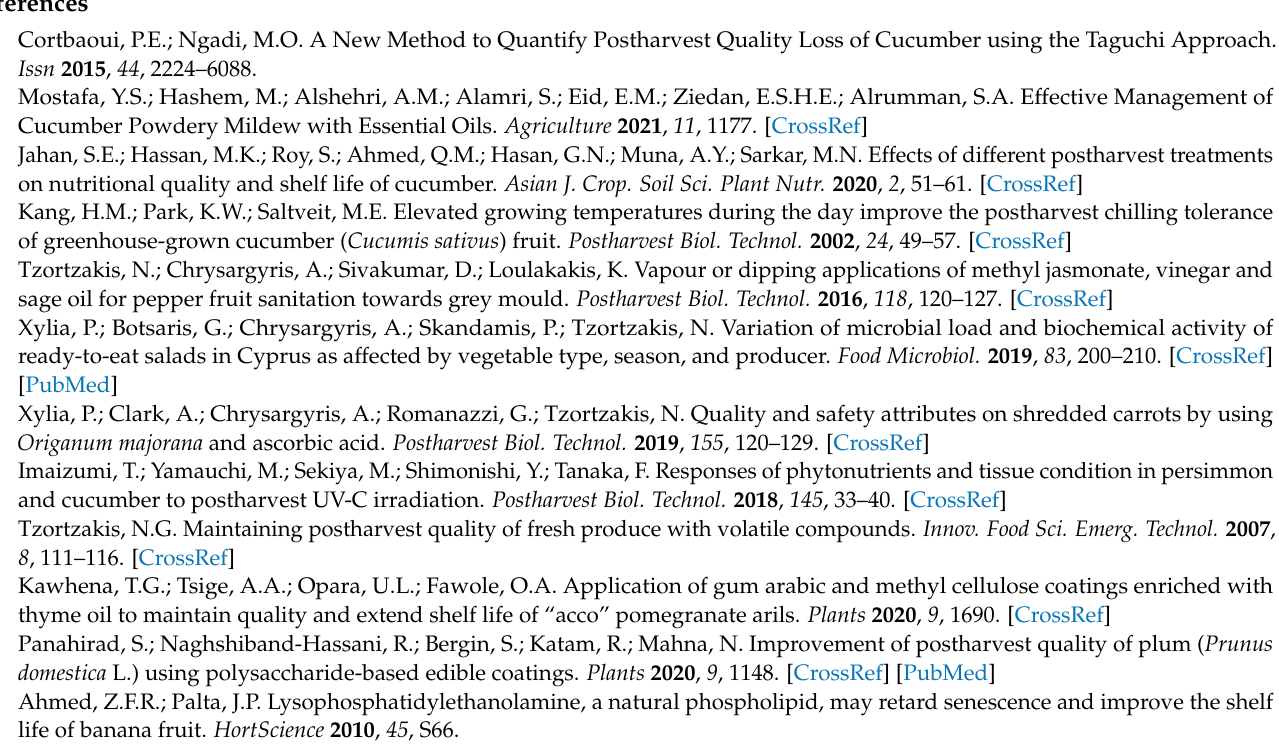
Figure A2. Effect of dipping or vapour EP applications.